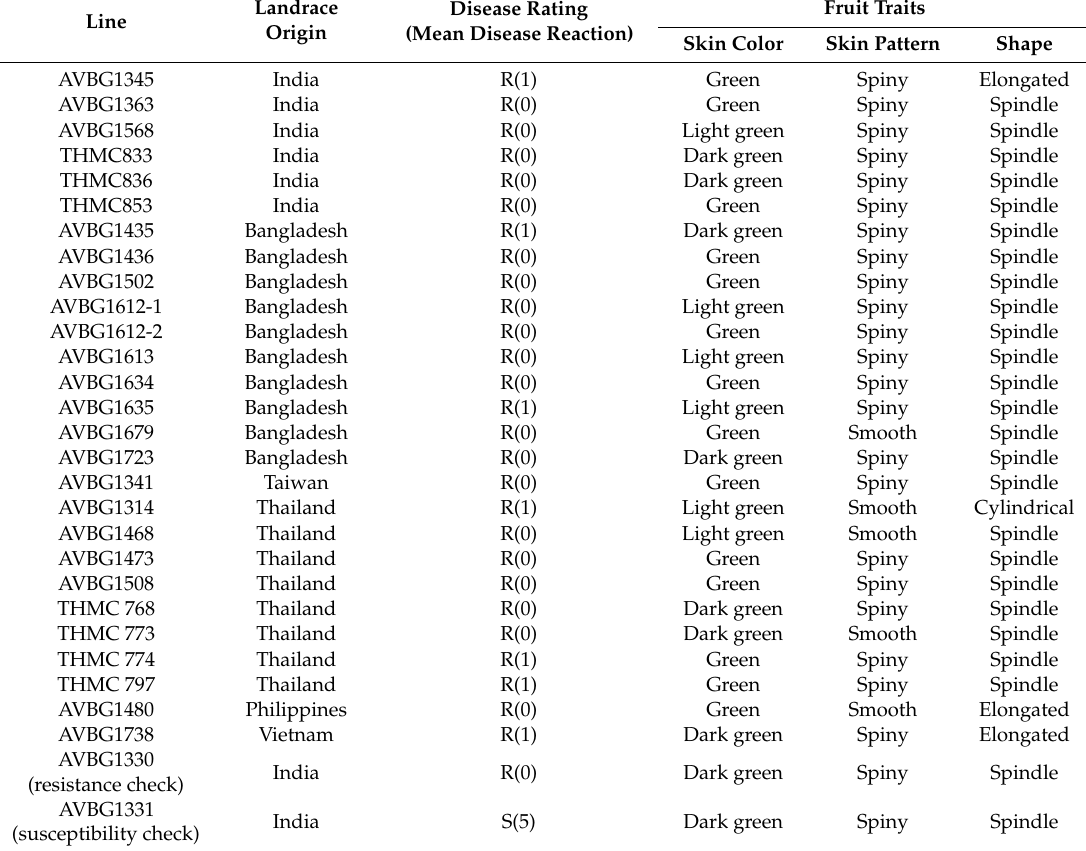
Table 1. Cucurbit powdery mildew (CPM)(caused by Podosphaera xanthii ) disease severity scored 12 days after the third artificial inoculation, measured using 28 bitter gourd breeding lines and the